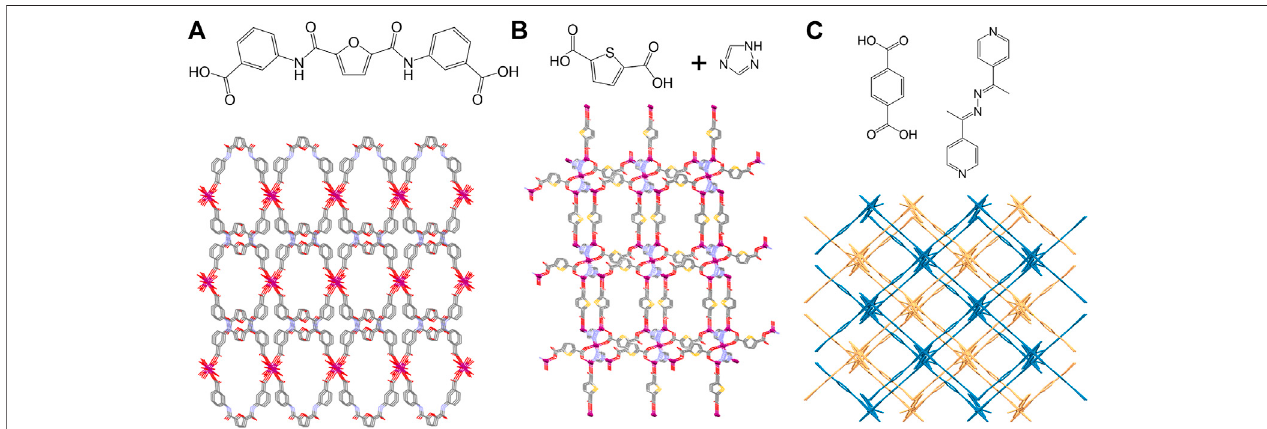
FIGURE 2 | Some representative structures of Zn-MOFs for biologically and environmentally relevant analytes. (A) Ligand and 3D structure of Zn (II) MOF BIPT-1 viewed along the c axis, form ref (Qu et al., 2018). (B) Ligands and 3D framework of Zn (II) MOF along the a axis, form ref (Zou et al., 2018). (C) Ligands and the two-fold interpenetration TMU-16, form ref (Farahani and Safarifard, 2019).